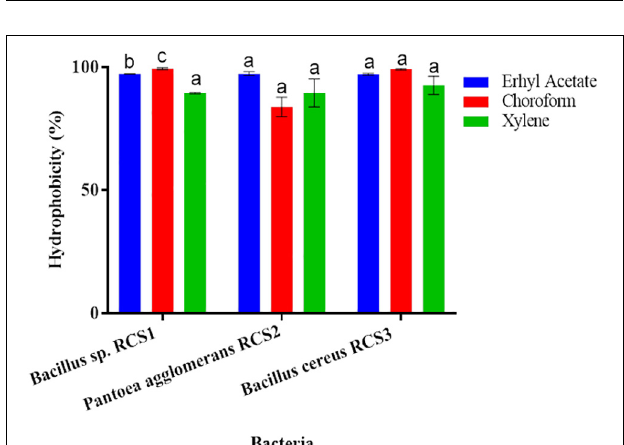
FIGURE 6 | Cell surface hydrophobicity of bacterial strains to various solvents (such as Ethyl acetate, Chloroform and Xylene). Values are presented as mean ± SE. Different letters (a, b, and c) indicate significant differences ( P < 0.05).